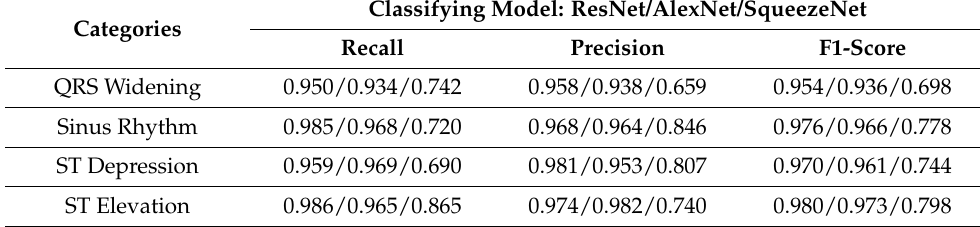
Table 3. The metrics for each class and three different models.